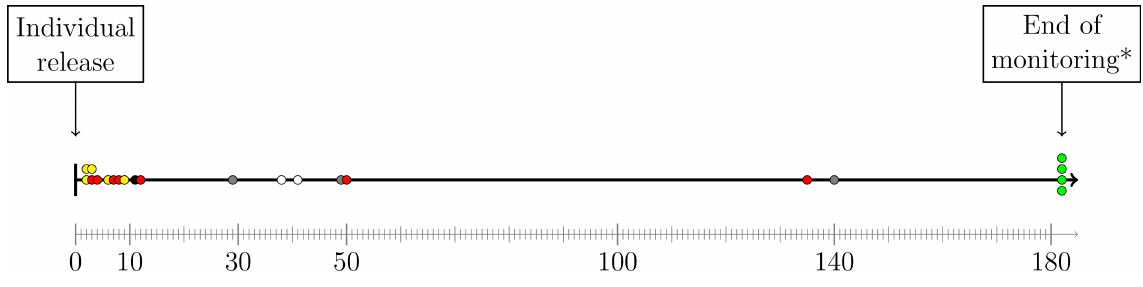
Fig 2. Survival duration of hares according to cause of death: red –predation by red foxes, yellow –health problems, black –lost transmitter, gray – hit by car, white –unidentified, green –survived monitoring period. Gray axis below depicts days from individual